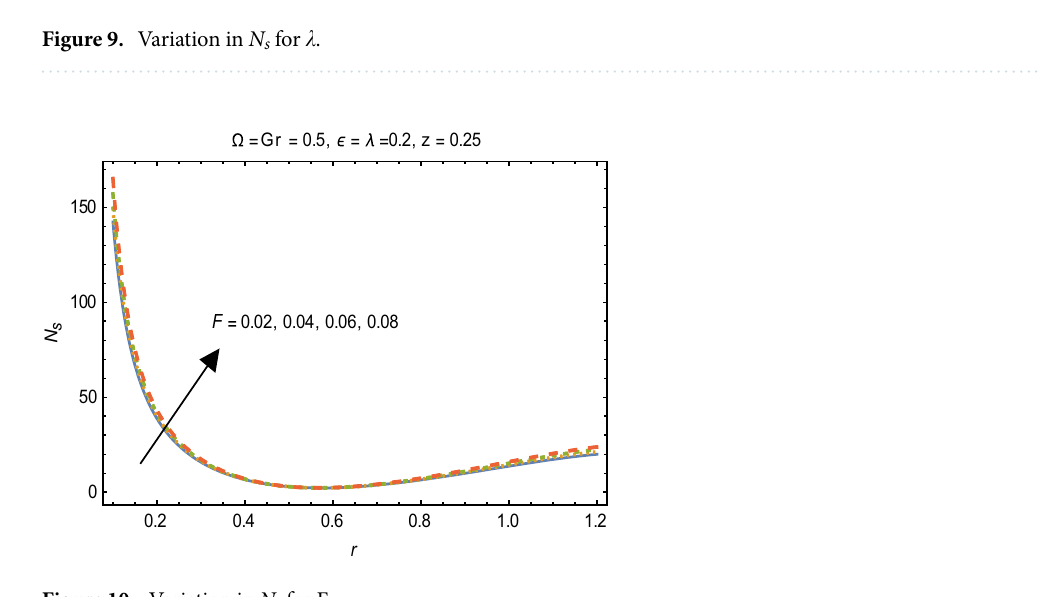
Figure 10. Variation in N s for